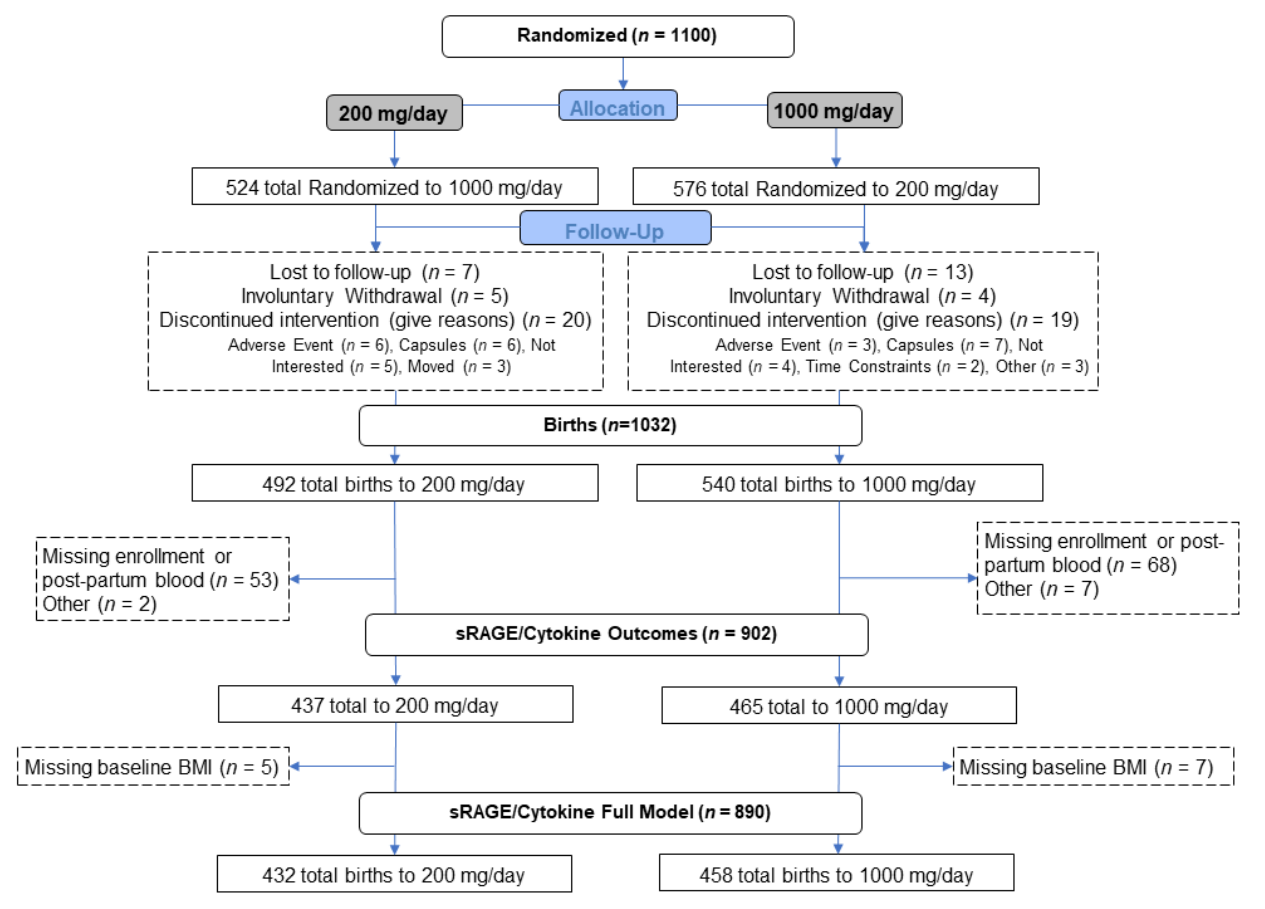
Figure 1. Study Design and Enrollment.